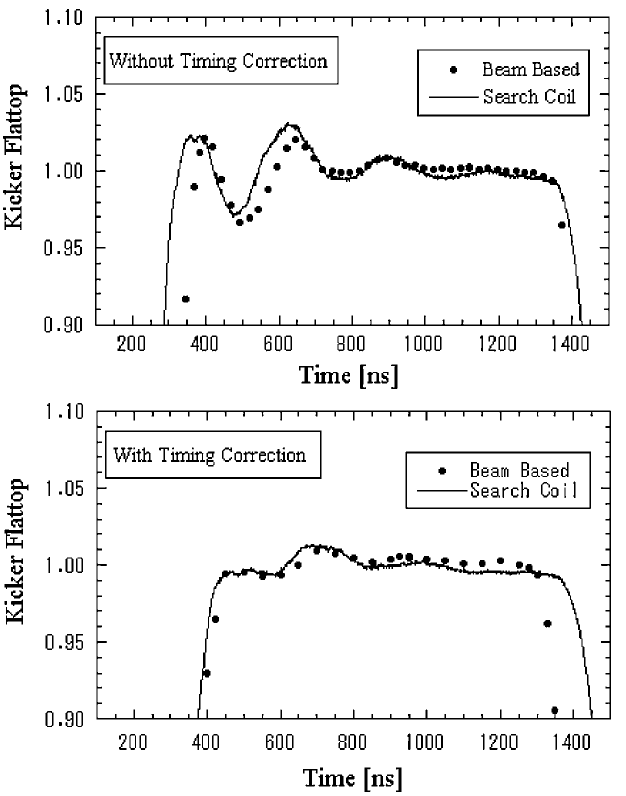
FIG. 8. Kicker flattop measured by the beam position (closed circles) and the search coil (solid line). The upper graph shows the results without timing correction, while the lower shows the results with timing